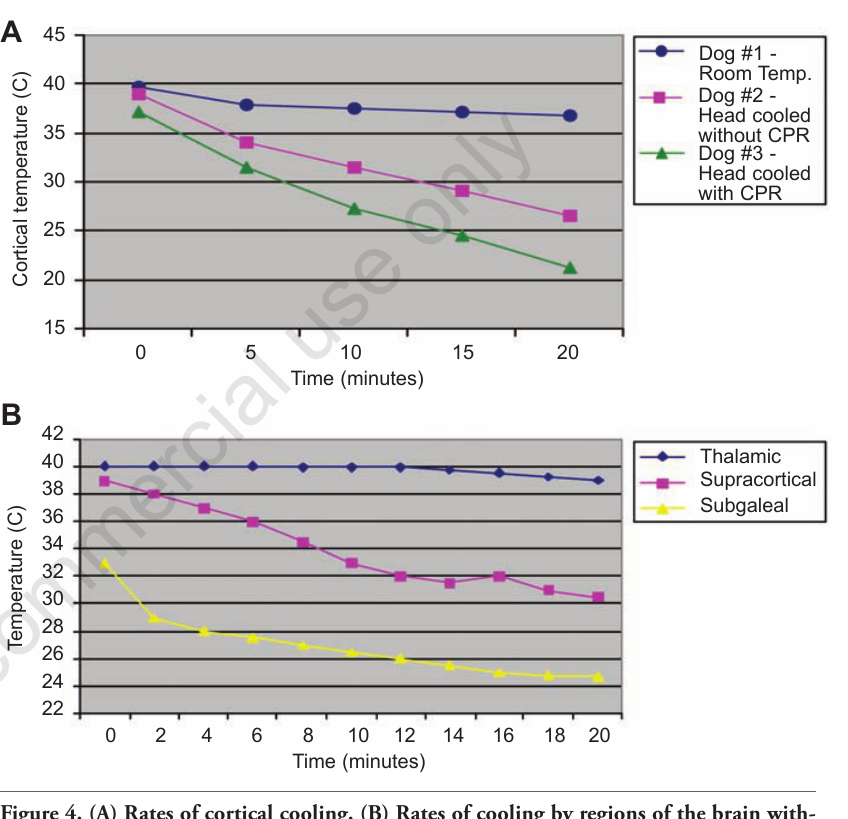
Figure 4. (A) Rates of cortical cooling. (B) Rates of cooling by regions of the brain with- out cardiopulmonary resuscitation.